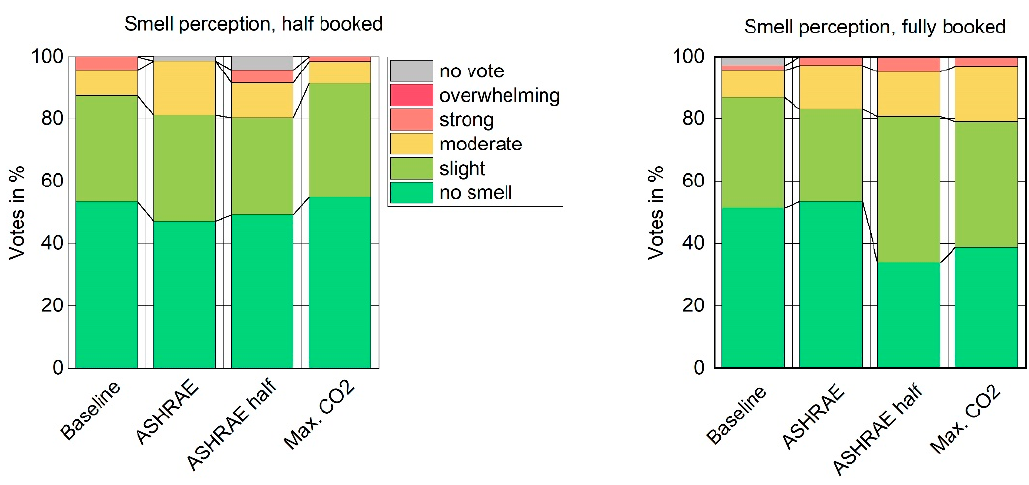
Figure 15. Smell perception votes for the different outdoor airflow rates. Left : uncongested, Right : Fully booked.